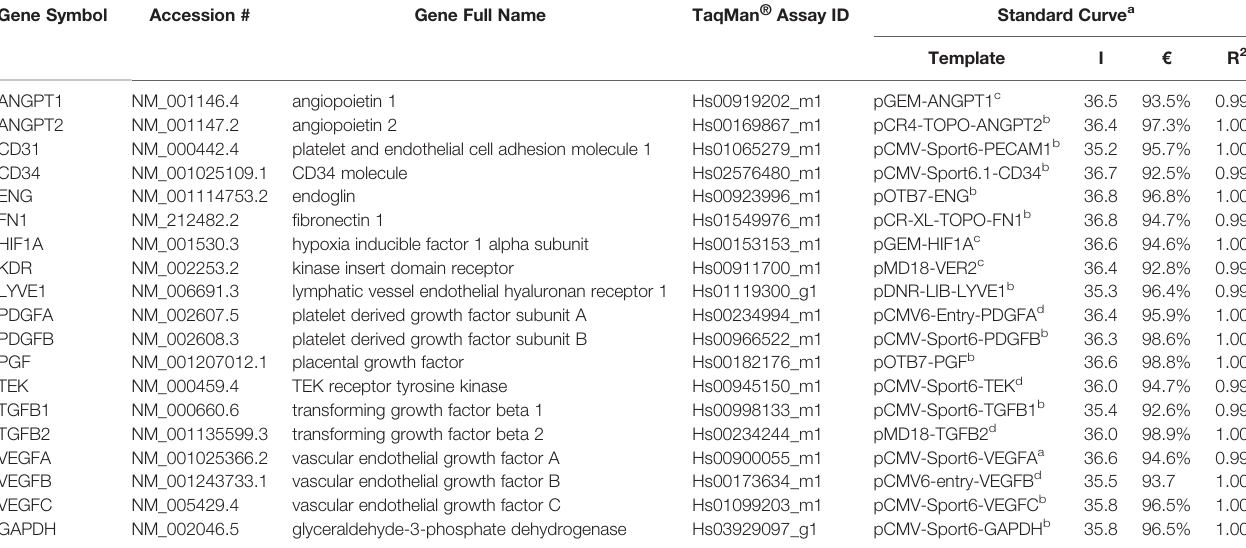
TABLE 2 | Genes, TaqMan ® Probes, and qPCR Standard Curve